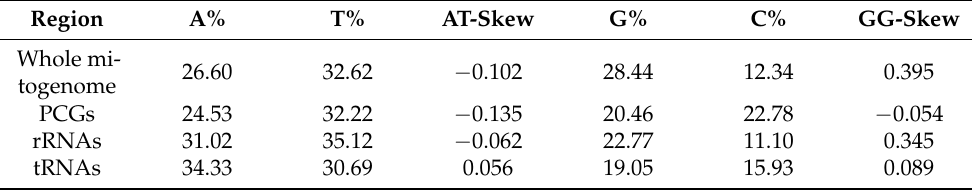
Table 3. Composition and skewness in the mitochondrial genome of S. bungii